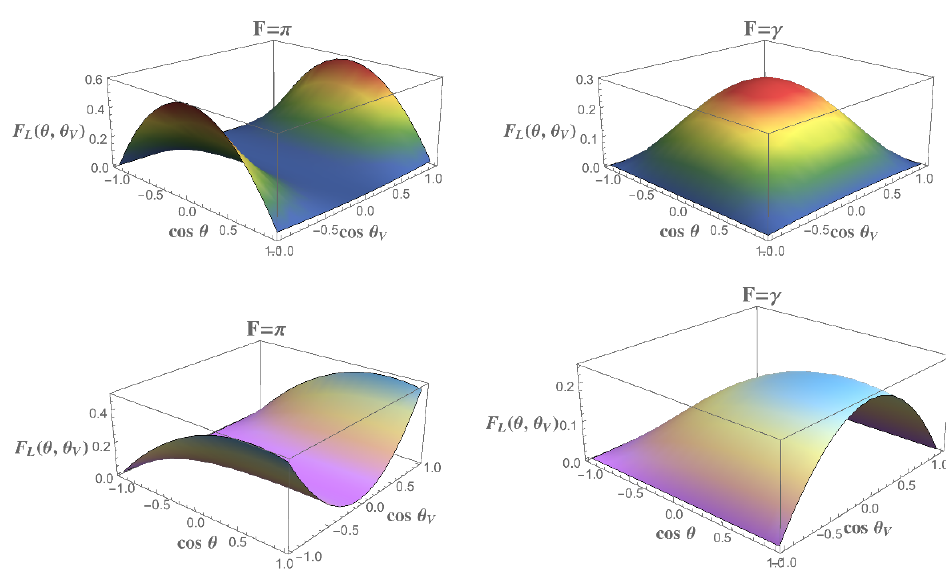
Figure 12 . SM distributions F L ( (cid:18); (cid:18) V ) de(cid:12)ned in eq. (6.13). Upper and lower plots refer to ‘ = (cid:22) and ‘ = (cid:28) , respectively, the left and right column to F = (cid:25) and F = (cid:13) . Figure 13 . SM distributions F T ( (cid:18); (cid:18) V ) de(cid:12)ned in eq. (6.14). Upper and lower plots refer to ‘ = (cid:22) and ‘ = (cid:28) , respectively, the left and right column to F = (cid:25) and F = (cid:13) . { 22